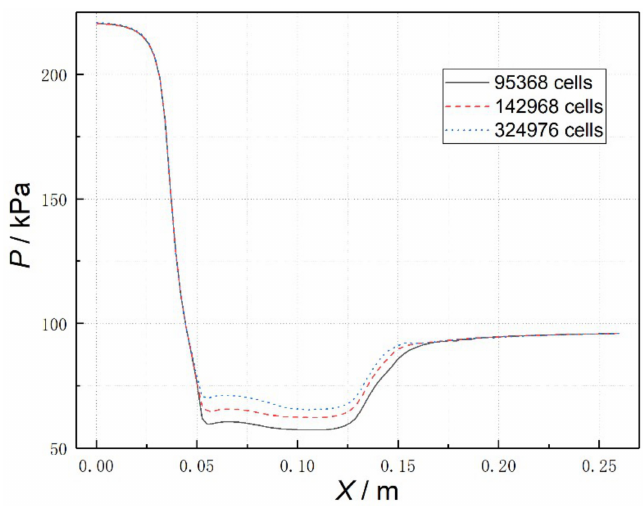
Figure 3. Mesh independency check, m β 1 = 0.0102 kg/s, T β 1 = 398 K, m α 1 = 0.49 kg/s, T α 1 = 290 K.